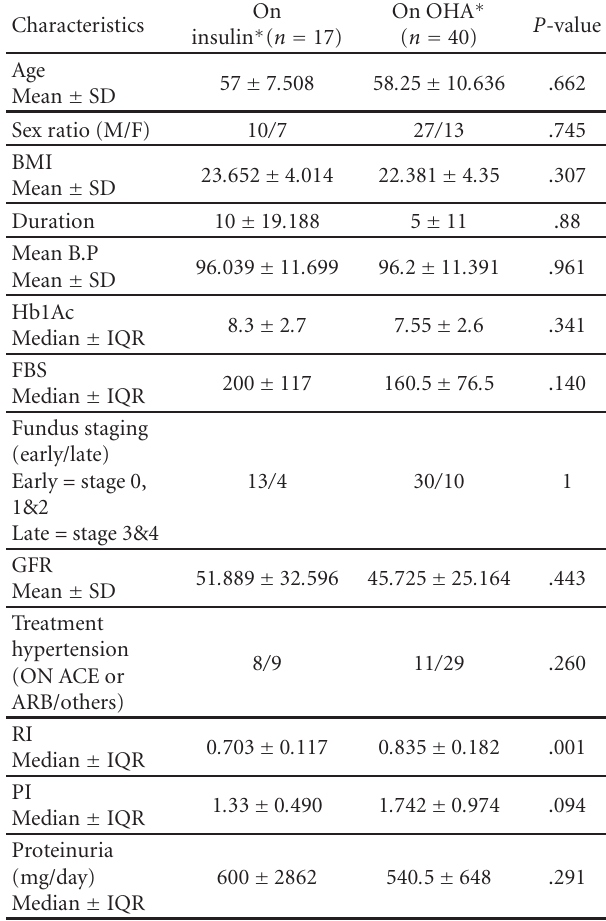
Table 5: Comparison of patients between treatment groups.